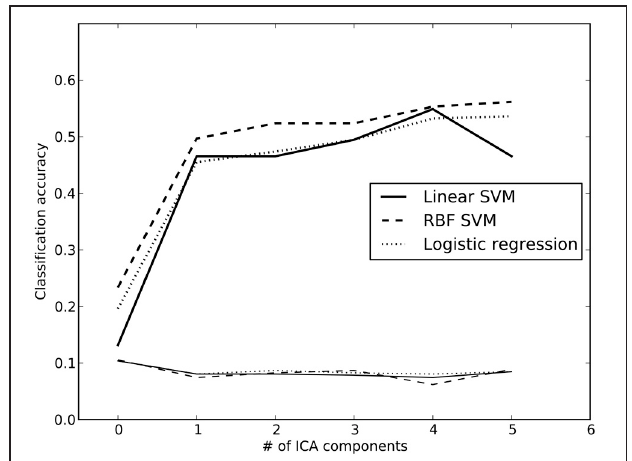
FIGURE 3 | Classification accuracy using reduced-dimension data, as a function of the number of ICA components in the dimensionality reduction step. Dimensionality reduction was first performed on an independent set of data (from run 2 for each subject), and the data from run 1 were then projected onto those components. Reported accuracy (thick lines) reflects average accuracy of task classification across all data points, from a total of 25 possible labels. The thin lines at the bottom reflect the empirically derived 95% cutoff for the null hypothesis of chance accuracy, obtained by performing the same classification 100 times with randomized labels, and taking the 95th largest value. RBF, radial basis function; SVM, support vector